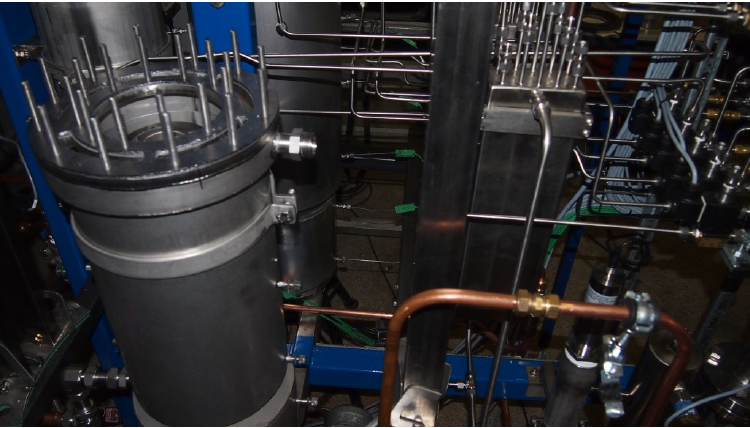
Figure 15. Picture of the prototype reactor for the Oxidative Coupling of Methane (OCM) process.